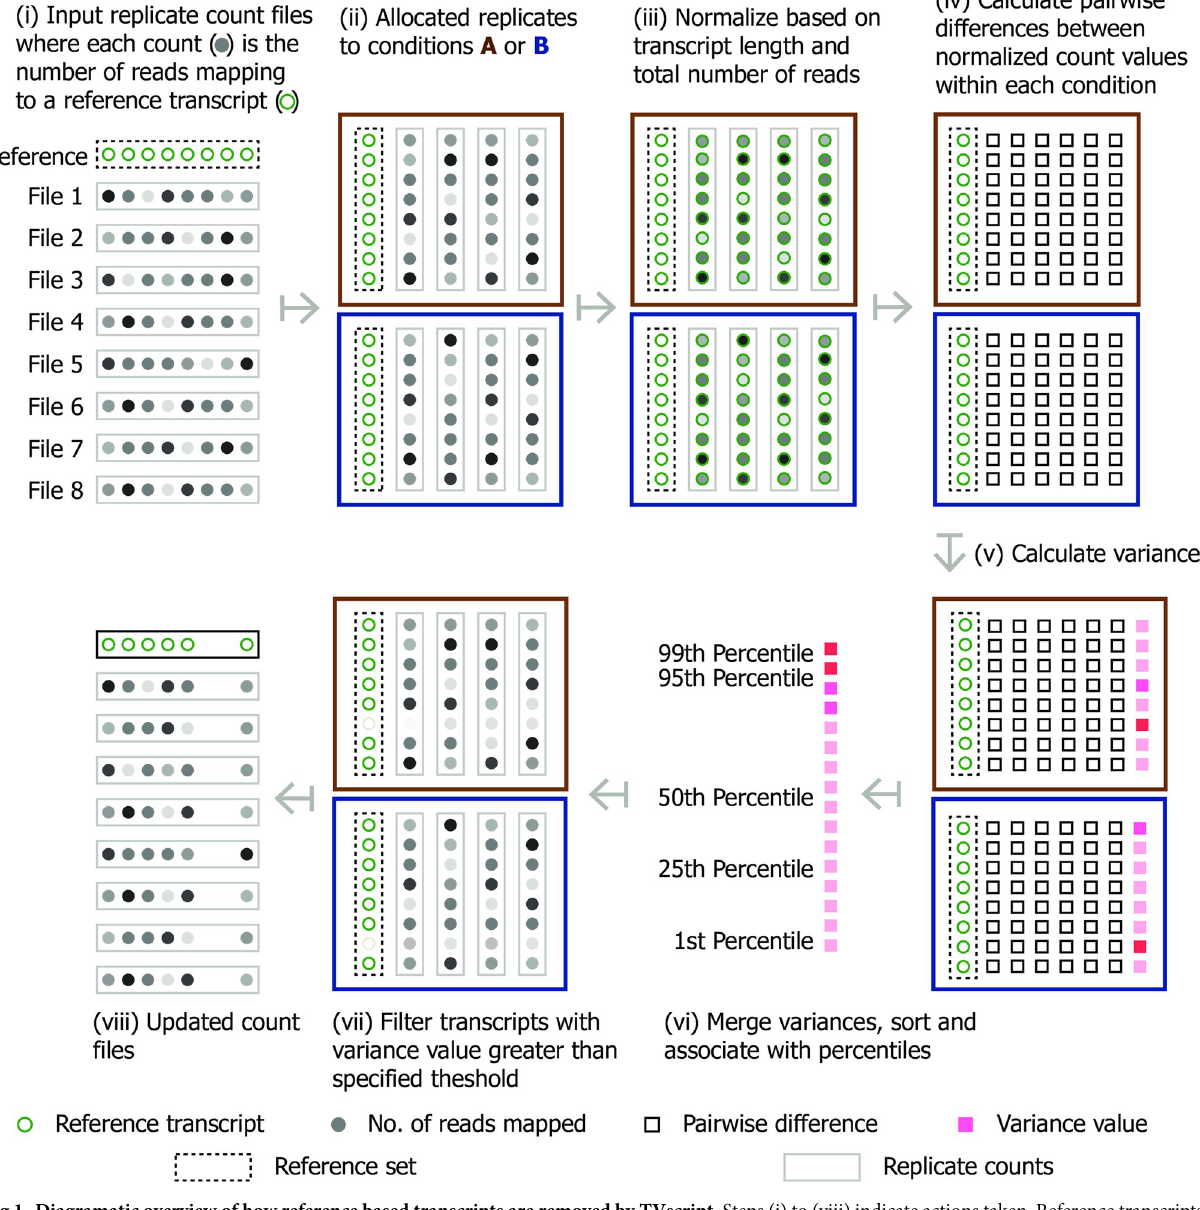
Fig 1. Diagramatic overview of how reference based transcripts are removed by TVscript. Steps (i) to (viii) indicate actions taken. Reference transcripts (green circles) are showen for diagramtic purposes in order to highlight how read counts (grey circles) across replicates are treated for each transcript independently. Read counts are grouped into individual files (gray rectangles) in accordance to replicate. These files are grouped into one of two conditions (blue and brown boxes). Remaining keys are indicated at the